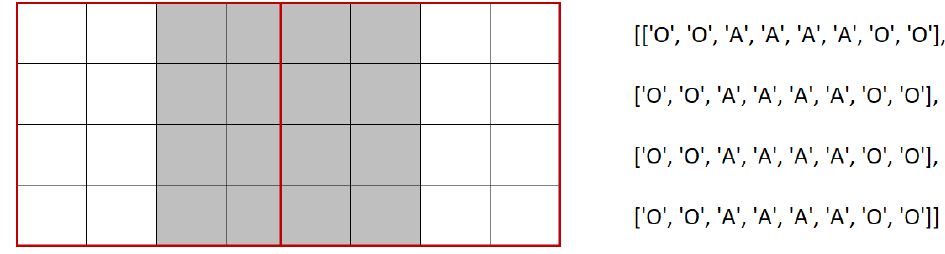
Figure 7. Representation of a possible building consisting of 2 BGs.